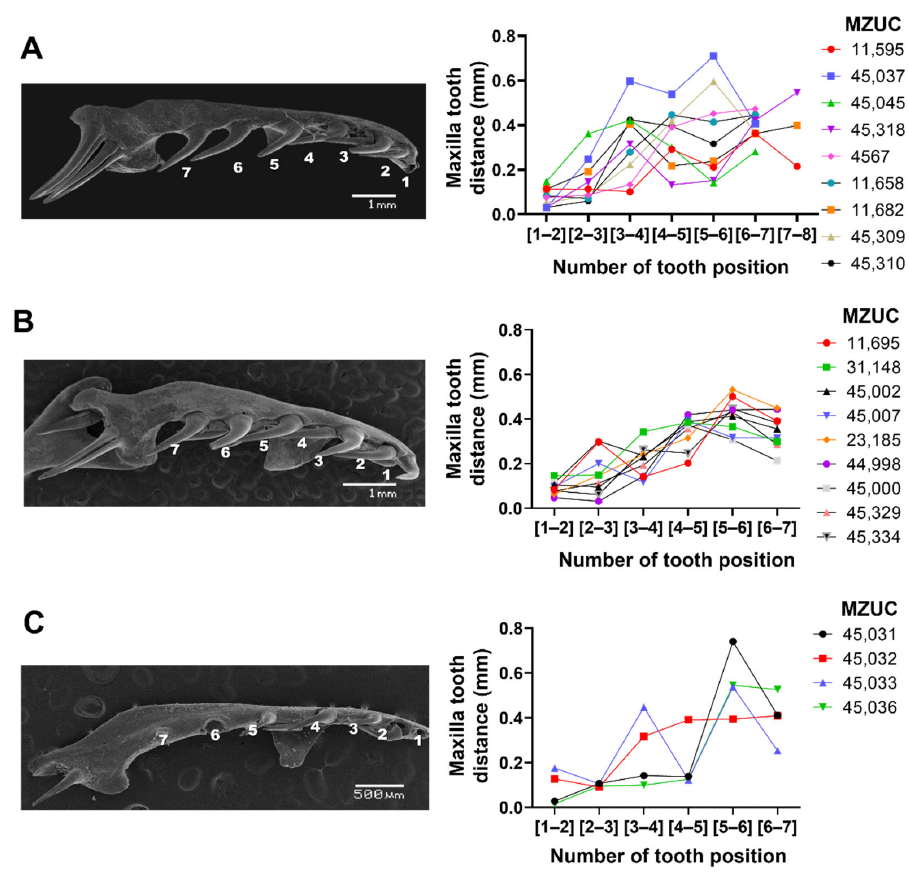
Figure 2. Variation of distances between teeth of the maxilla in ( A ) adults, ( B ) juveniles, and ( C ) neonates of Galvarinus ch. chilensis (labial view). The vouchers of specimens used for quantification are indicated in each graph. Data shown are mean ± SD from adults (N = 9), juveniles (N = 9), and neonates (N = 4). Representative images were obtained by scanning electron microscopy from ( A ) adult MZUC 45,037, ( B ) juvenile MZUC 11,695, and ( C ) neonate MZUC 45,032.